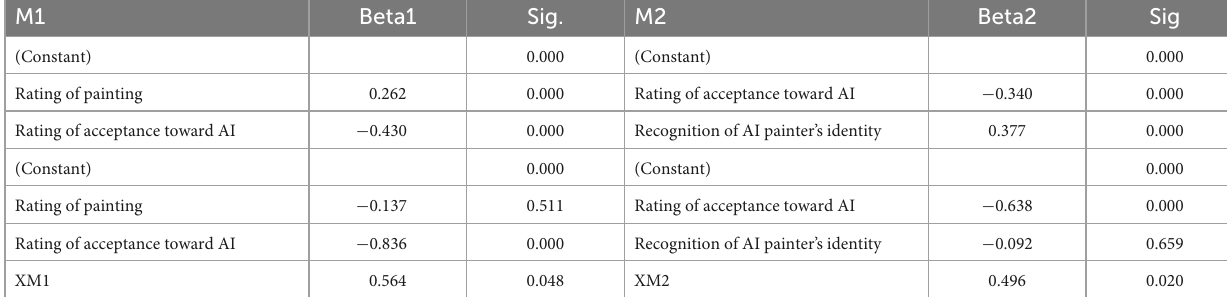
TABLE 6 Moderating effect of willingness to use AIGC for